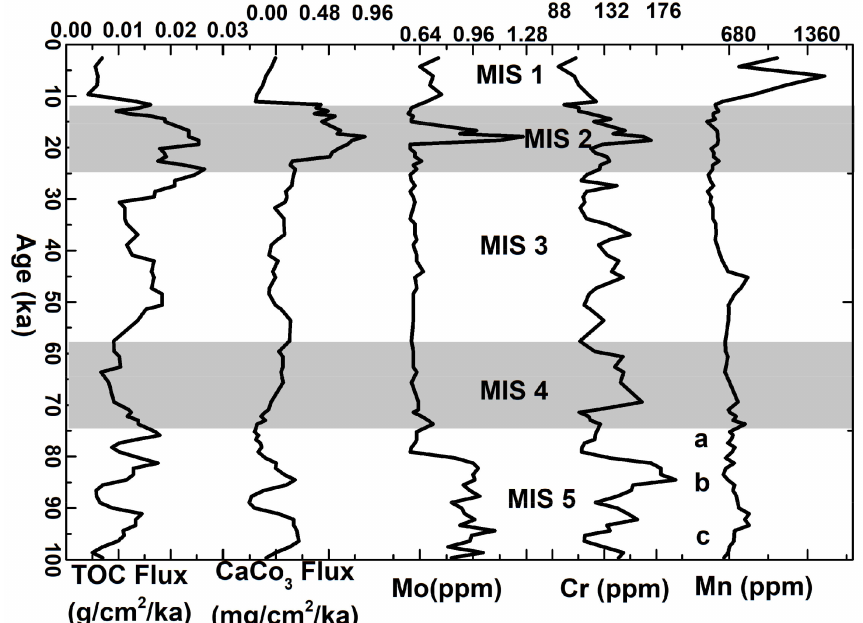
Figure 5. Down-core trend in the flux of TOC and CaCO 3 [8], Mo and Cr and Mn during the past 100 ka in the eastern Arabian Sea.